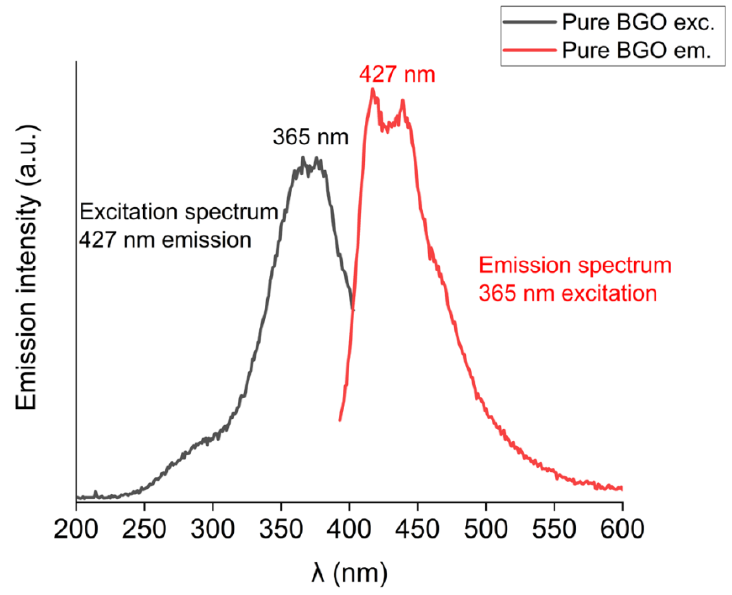
Figure 7. The Bi 3 + ion excitation and emission spectrum in BGO (T = 300 K). The emission profile of Eu:BGO can be seen in Figure 8, as expressed in CIE 1976 color space.